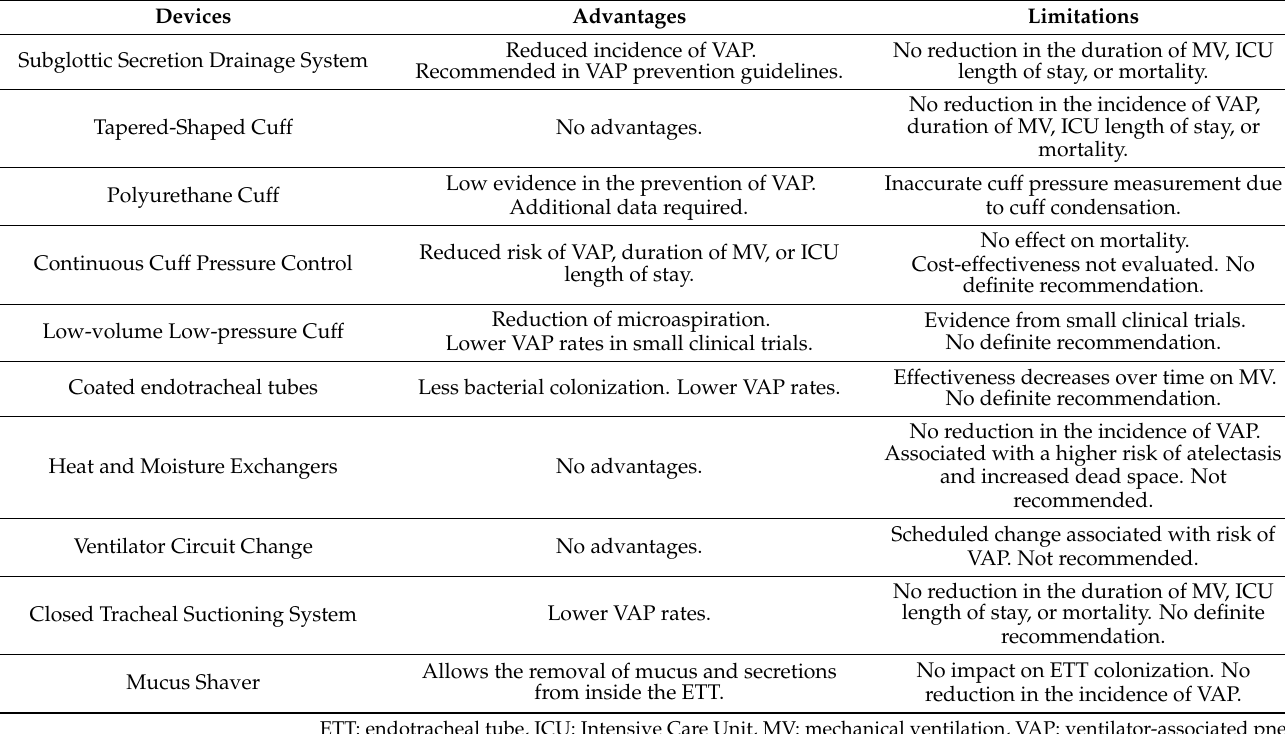
Table 1. Main characteristics of airway and respiratory devices.